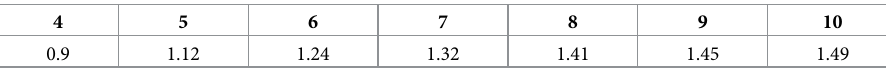
Table 4. Random consistency index